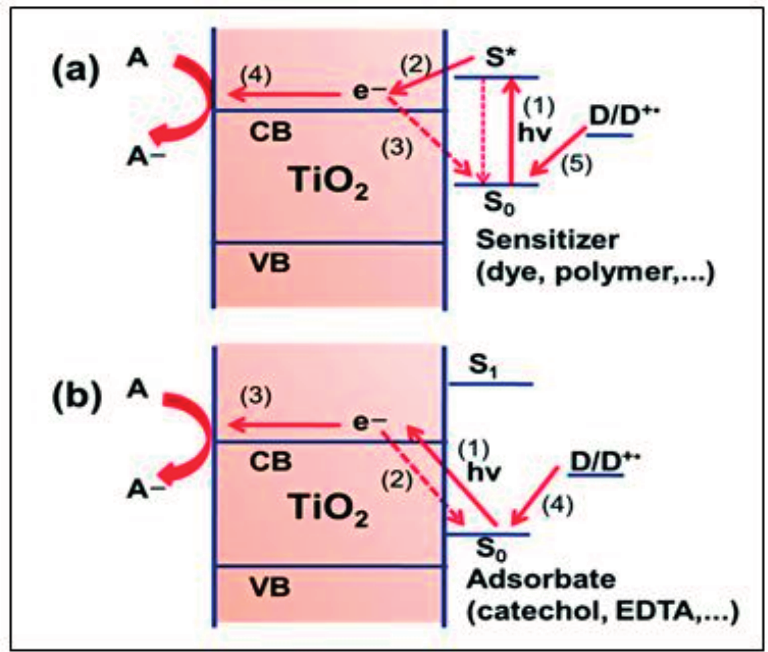
Figure 7. Scheme of charge transfer modes from sensitizer (S) to the TiO 2 conduction band (CB): ( a ) indirect (type I); ( b ) direct (type II or LMCT) (reproduced from [95] with permission of the Royal Society of